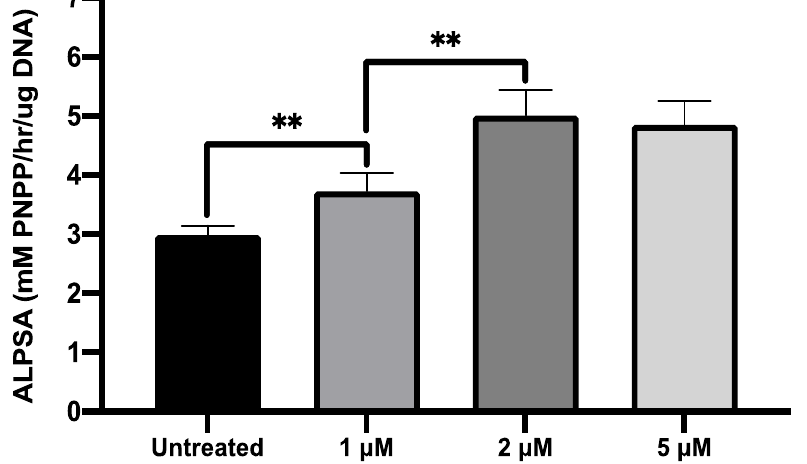
Figure 5. Effect of MI192 pre-treatment on hDPSCs ALPSA. Cells were pre-treated with/without MI192 for 48 h before culture in osteogenic conditions for 14 days. Data are expressed as mean ± SD ( n = 3). ** p ≤ 0.01.